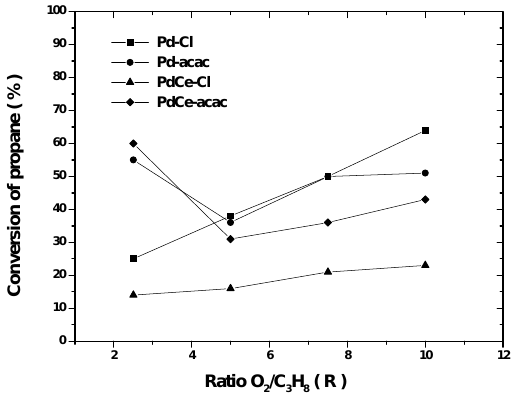
Fig. 1 – Conversion of propane – the effect of the ratio oxy- gen/propane and the